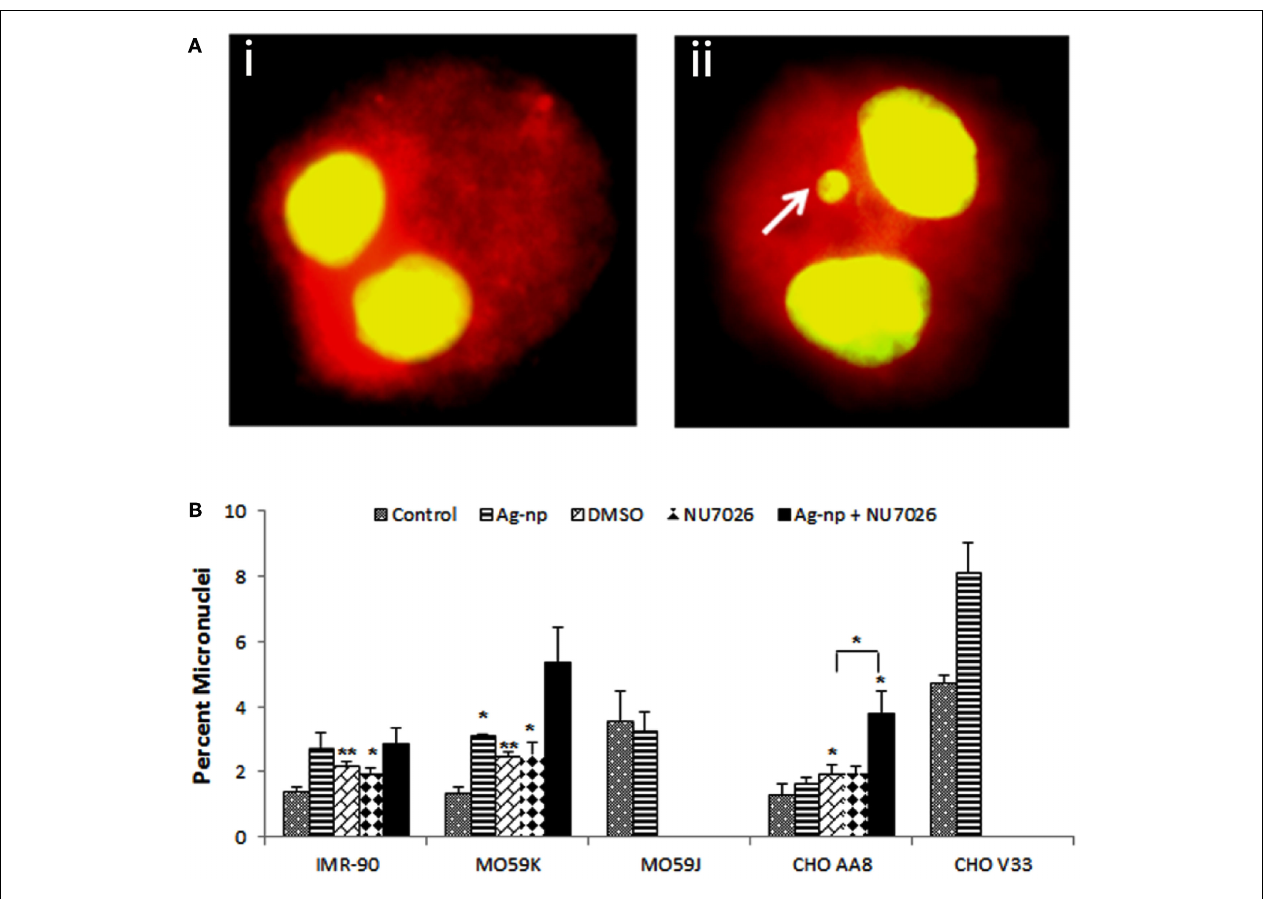
were stained with acridine orange (30 μ g/ml). Magnification = 60 × . (B) Data from CBMN show chromosomal aberrations.The data represent 1000 binucleated cells. *Denotes p < 0.05 and **denotes p <